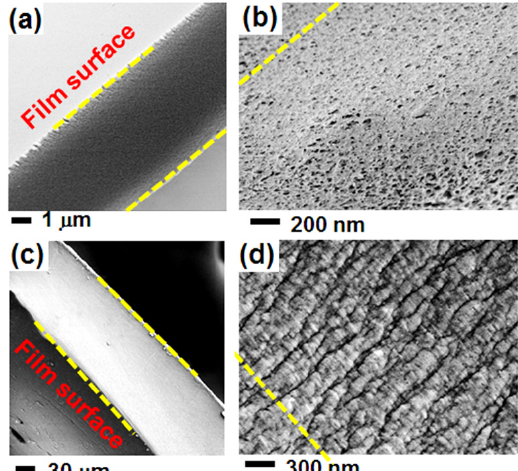
Figure 4. SEM images of sections of NC α form PPO films, as obtained by BE-induced crystallization on amorphous films, followed by BE extraction by scCO 2 . The thickness of the starting amorphous films is: ( a , b ) 20 µ m; ( c , d ) 100 µ m. The presence of flat-on lamellae is apparent only for the thicker film ( d ). The dashed yellow lines indicate the film surface direction.